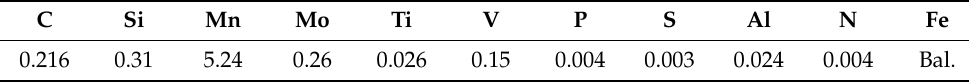
Table 1. Nominal chemical composition of the experimental steel